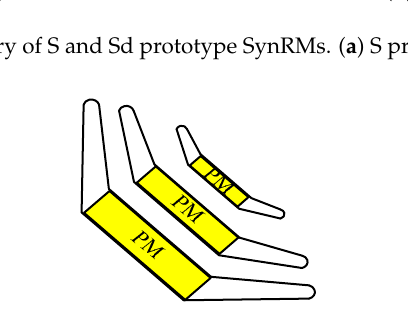
Figure 4. Flux-barriers with inserted ferrite permanent magnets (PMs). Table 2. SynRM abbreviations.